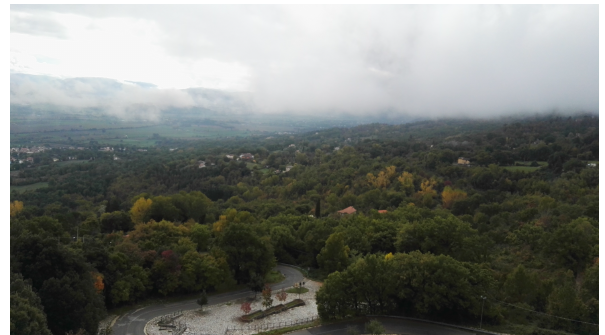
Figure 11. View from the monastery at Greccio, Italy, built on car- bonates and looking out at the fluvio-lacustrine and fan deposits. Photo credit: Ann C. Pizzorusso.